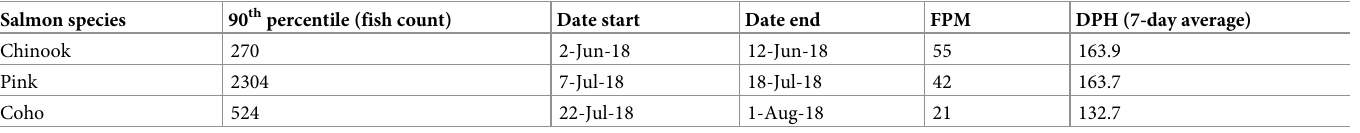
Chum and sockeye salmon runs sustained low fish counts and are not included in this